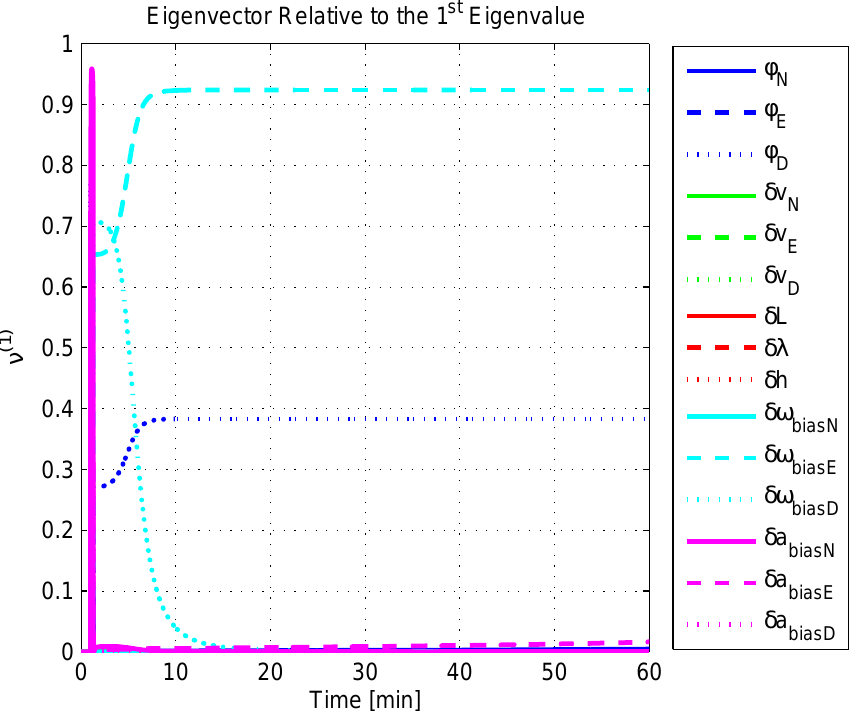
Figure 8. Eigenvector relative to the first eigenvalue in the simulated test.